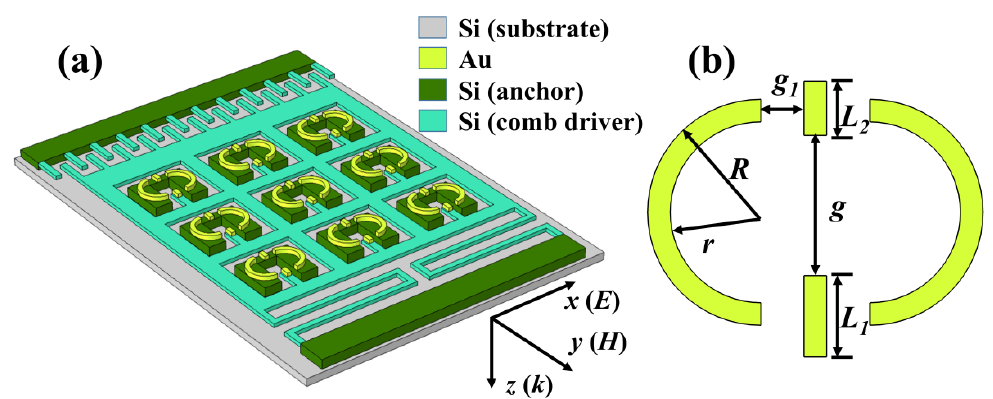
Figure 1. Schematic drawings of ( a ) 3D view of an electric split-ring resonator (eSRR) array and ( b ) geometrical denotations of an eSRR unit cell.